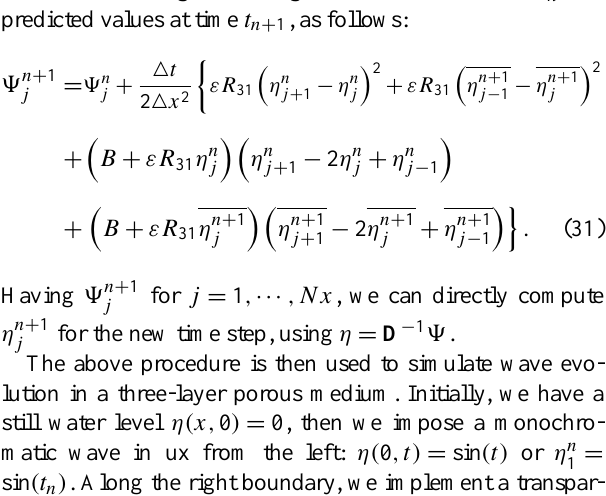
Fig. 3. Monochromatic waves enter the porous medium with four different scaled frequencies: !t = 0 , !t = (cid:25)= 2 , !t = (cid:25) , !t = 3 (cid:25)= 2 , computed using " = (cid:22) 2 = 0 : 3 . All four cases show the rising of mean water level as x ! 1 .